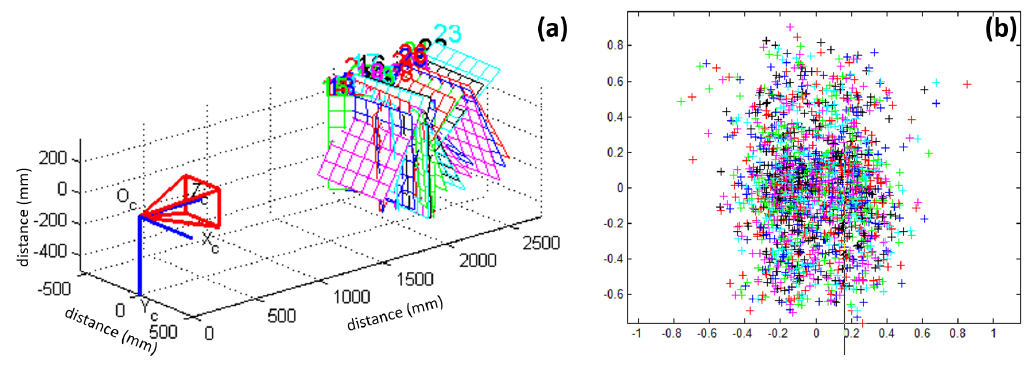
Figure 10. Calibrated camera system and its mapping effects. ( a ) The left camera model of the binocular vision system. ( b ) The projection error of the left camera system.